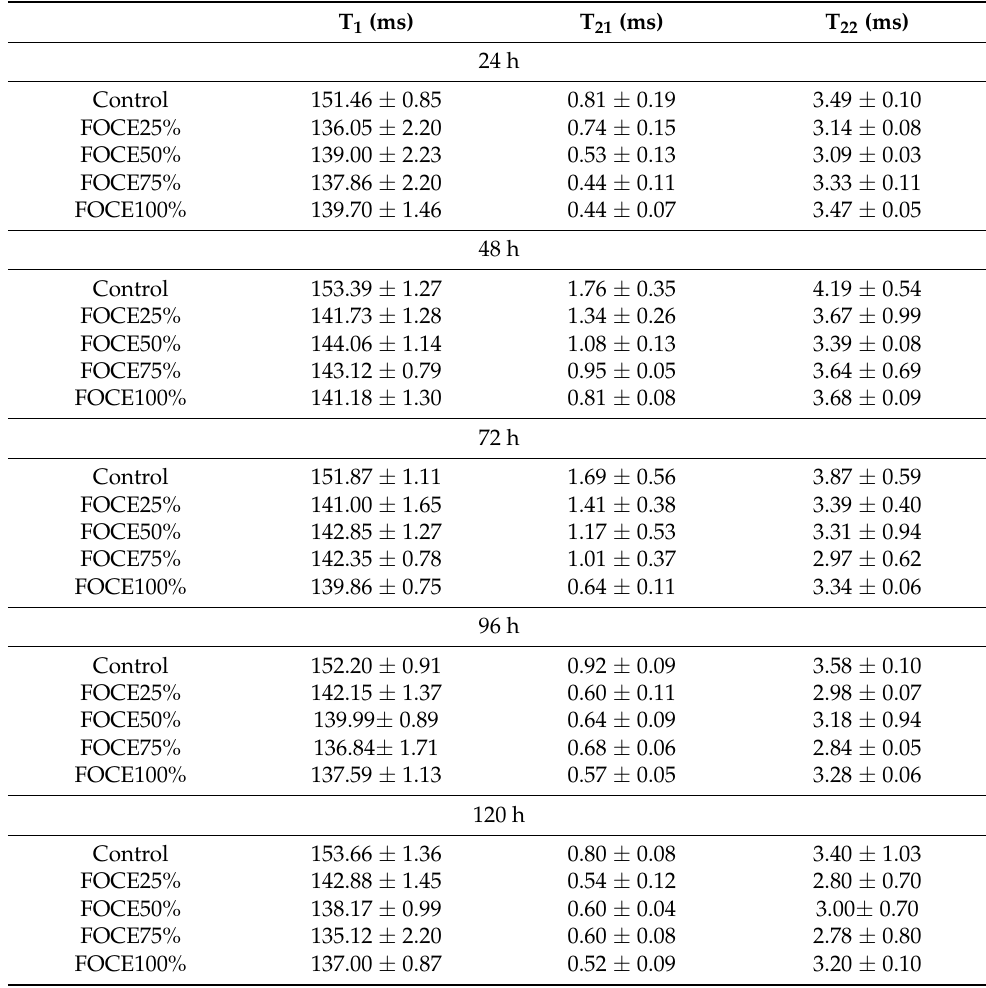
Table 4. LF NMR relaxometry measurement results of FOCE-containing